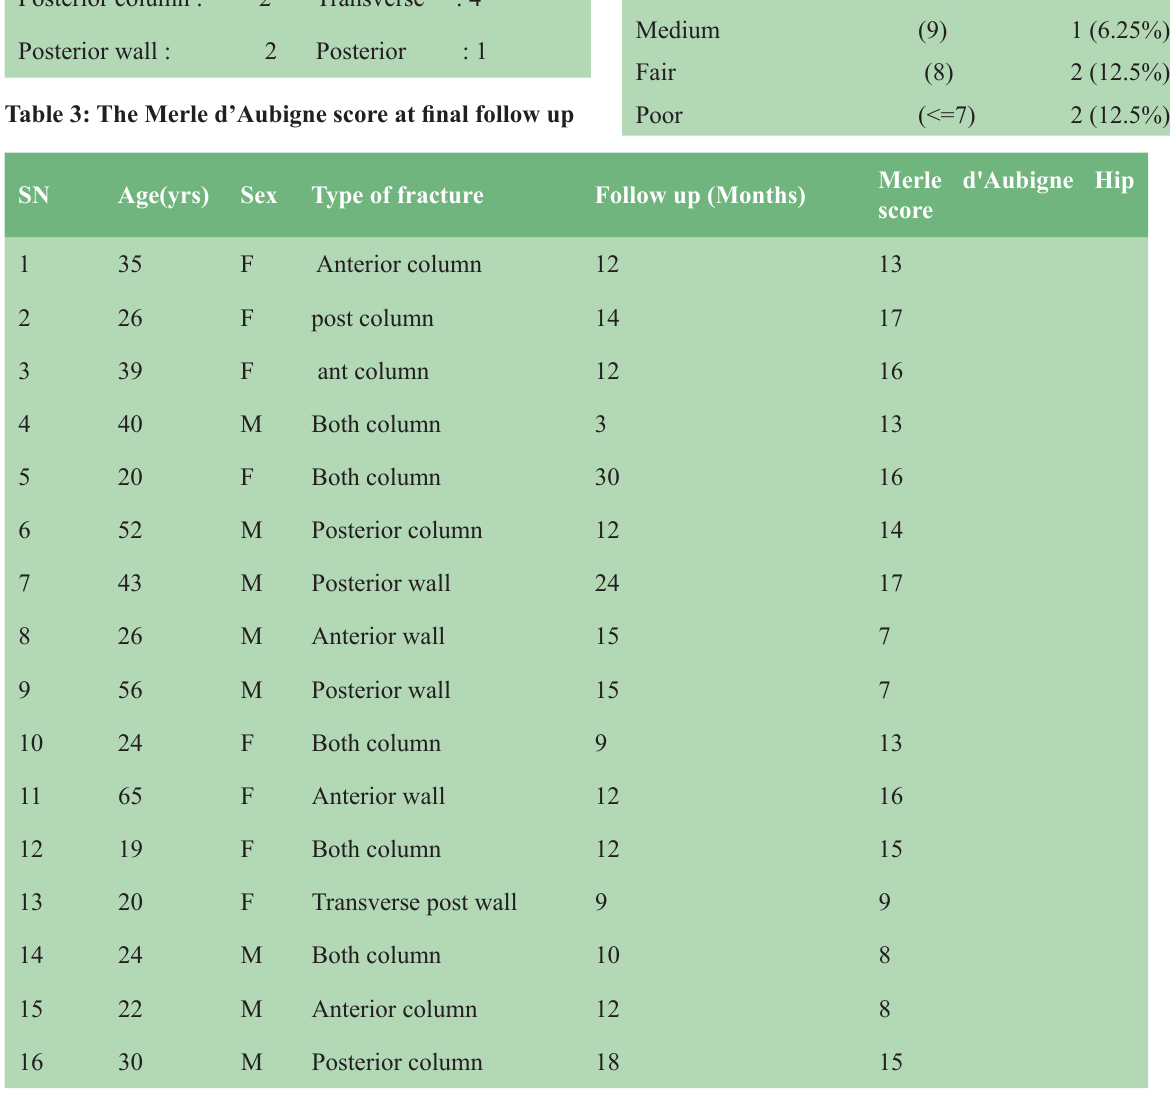
Table 3: The Merle d’Aubigne score at final follow up